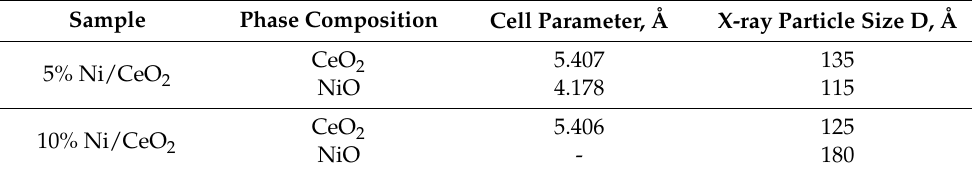
Figure 1. XRD patterns for 5% Ni/CeO 2 (1) and 10% Ni/CeO 2 (2) catalysts. Reflections of NiO are denoted by NiO (hkl), those of CeO 2 denoted by (hkl). Table 2. Structural data for catalyst samples.